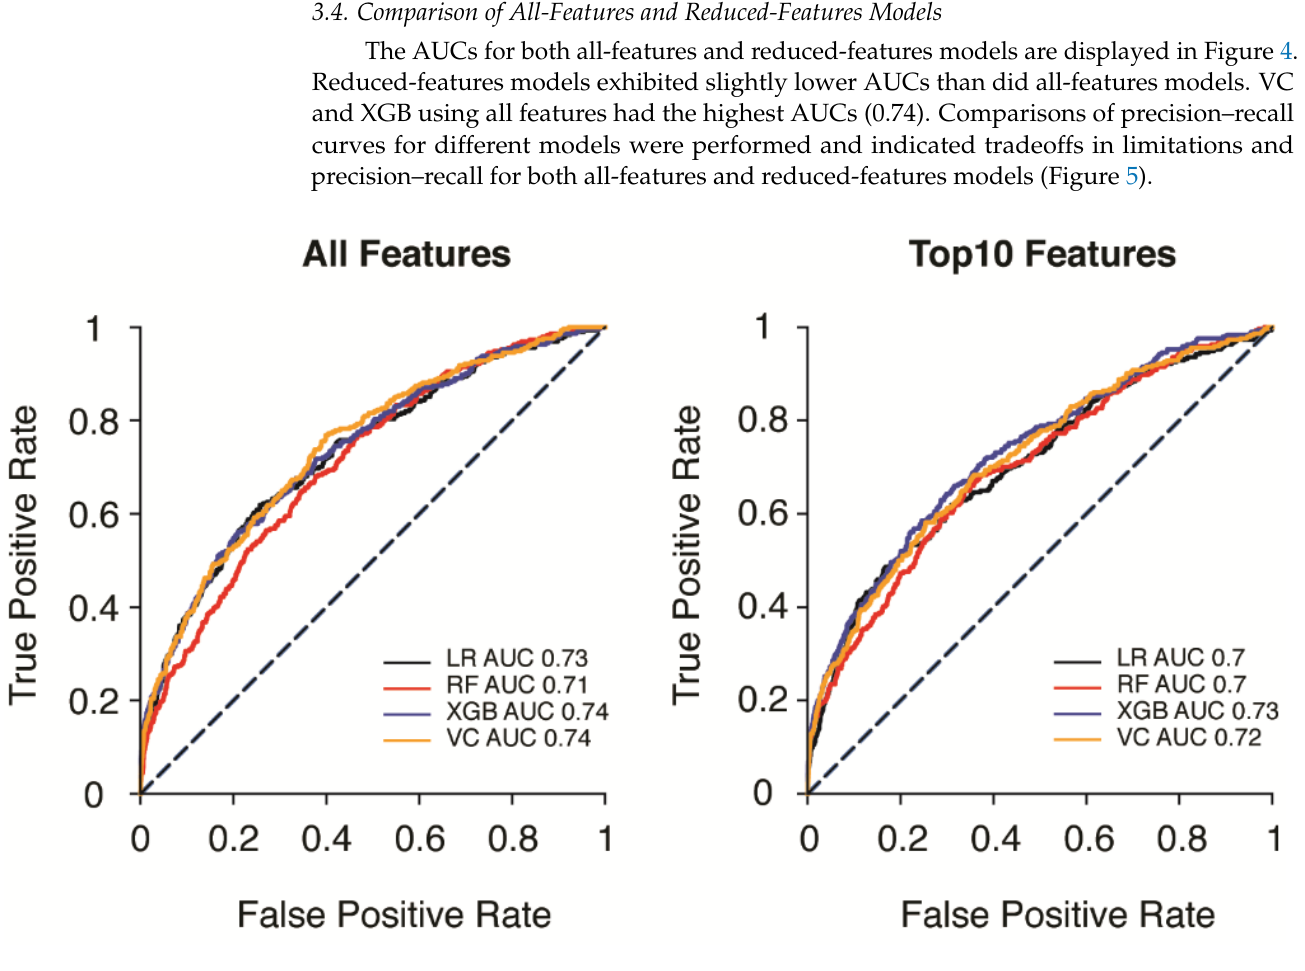
Figure 5. Comparisons of the precision–recall curves (PR curves) of different models in predicting unscheduled revisits to the emergency department within 72 h of discharge: ( left ) prediction made by using all collected features; ( right ) the same prediction made using only the top 10 features from each model (ranked by importance). The area under the PR curve is shown in parentheses. 4. Discussion To our knowledge, this study is the first to examine the use of machine learning in the prediction of 72 h URVs for patients with abdominal pain presenting to the ED. Pre- vious studies have reported prediction models using machine learning to predict 72 h URV for all causes, but no previous studies have focused on ED patients with abdominal pain [18,19,24]. One study examined the relationship between triage level and return visits in patients with abdominal pain, but the study lacked a prediction model for these patients [25]. Although predicting 72 h URVs for ED patients is considered crucial to improving the quality of care and patient safety, a 72 h URV is generally considered a complex and multicause event [2,3]. One difficulty in predicting 72 h URVs for ED patients is the com- plexity of the chief complaints and diseases. We attempted to focus on one specific group of ED patients to develop a better prediction result, but the results approximated those of previous studies. A possible explanation is the different medical approaches and culture in our country. Patients may not return to the same hospital after their first visit because